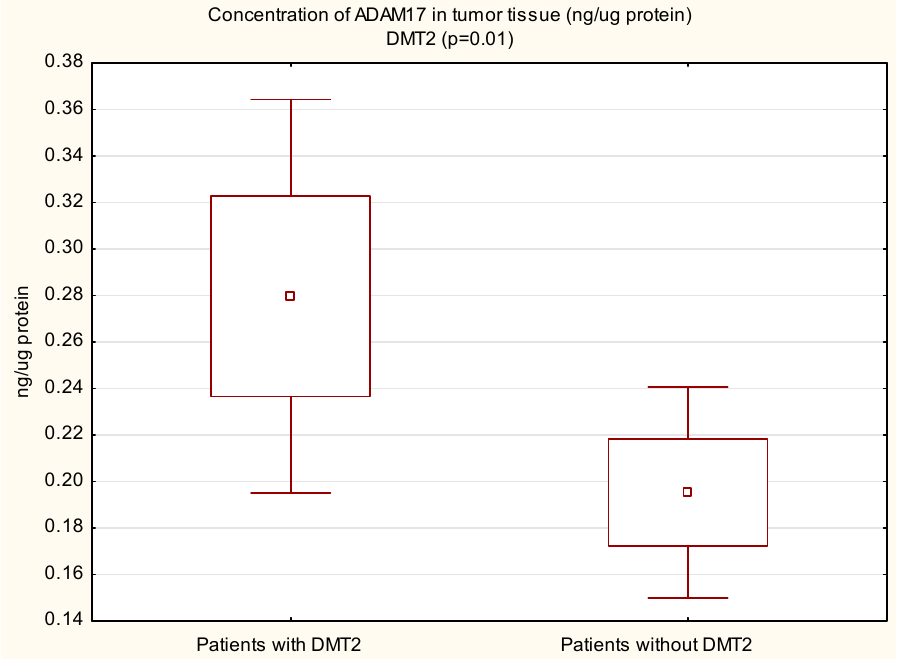
Figure 1. Concentration of ADAM17 protein in tumor tissue in CRC patients with and without coexisting diabetes mellitus type 2 (DMT2).